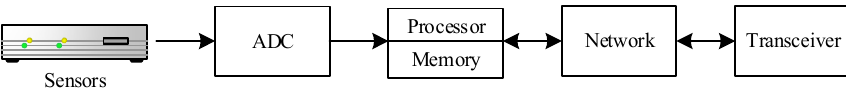
Figure 3. Sensor node